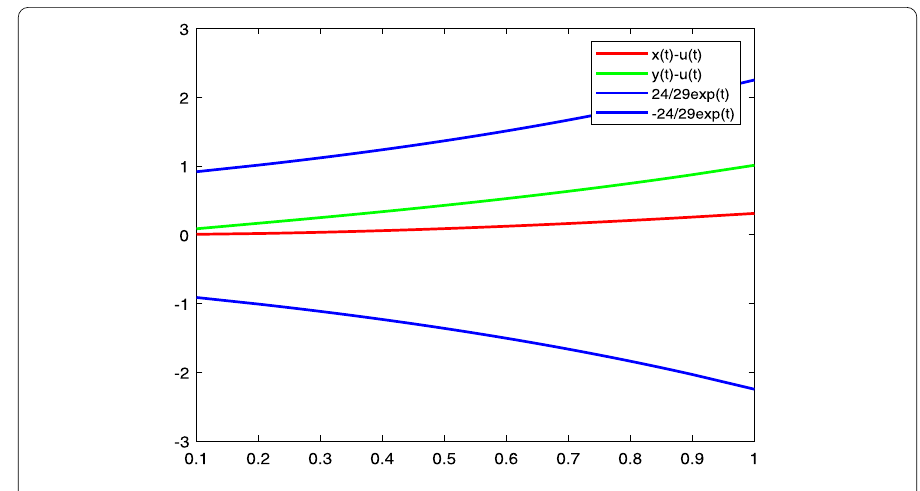
Figure 2 Functions x ( t ) – u ( t ), y ( t ) – u ( t ), and ± 24